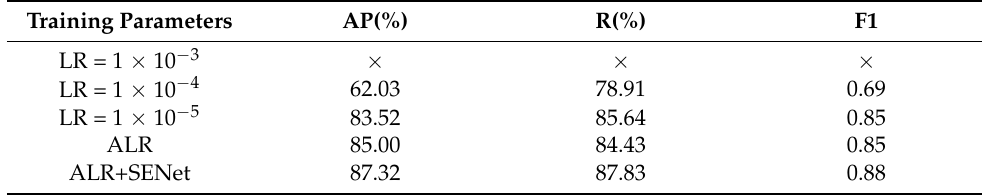
Table 3. Evaluation of training